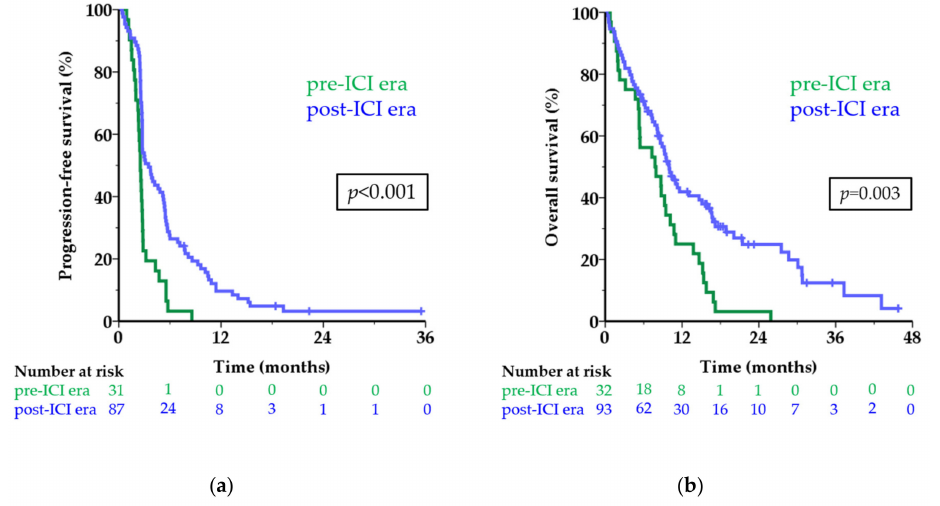
Figure 2. Survival before and after approval of first-line treatment with ICI. Kaplan-Meier curves showing progression-free survival ( a ) and overall survival ( b ) in the pre-ICI era (green line) and post-ICI era (blue line) in months for patients with metastatic uveal melanoma. The numbers below the figures denote the number of patients ‘at risk’ in each group. Abbreviations: ICI, immune checkpoint